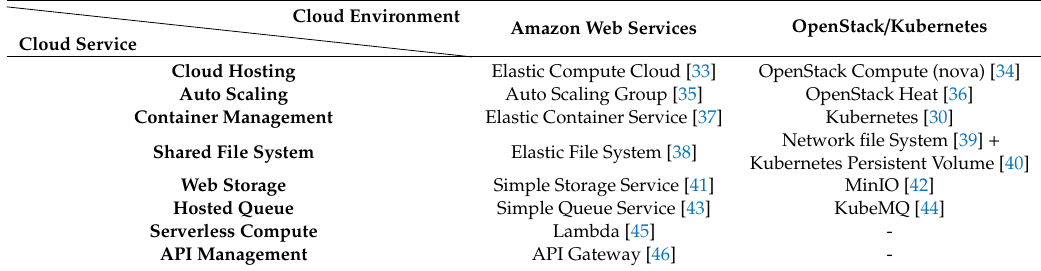
Table 1. Cloud Services utilized by VLab deployments for di ff erent cloud environments.